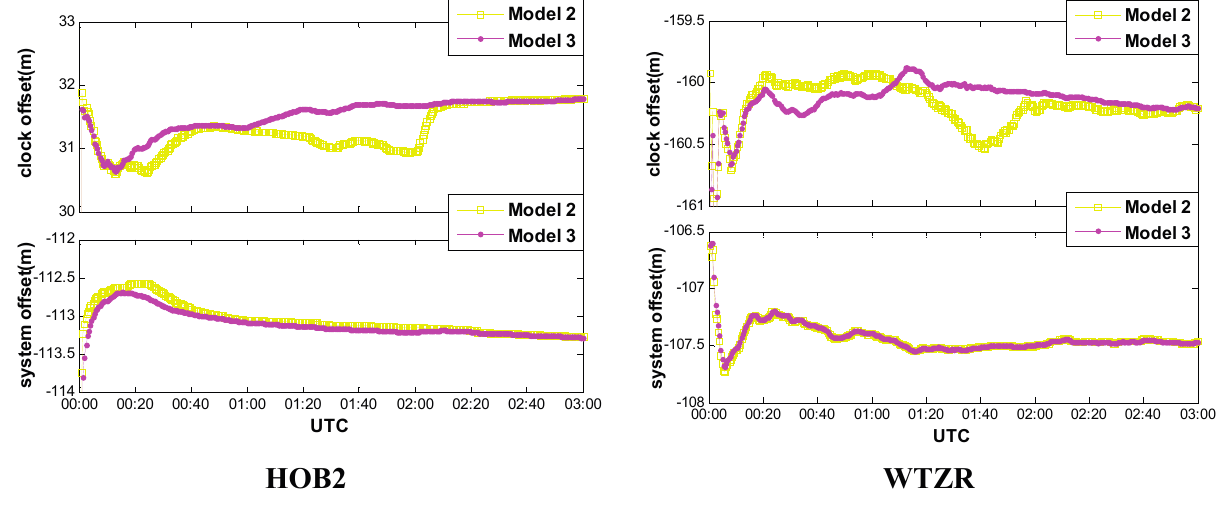
Figure 6. Receiver clock offset and ISB of GPS/GLONASS combined